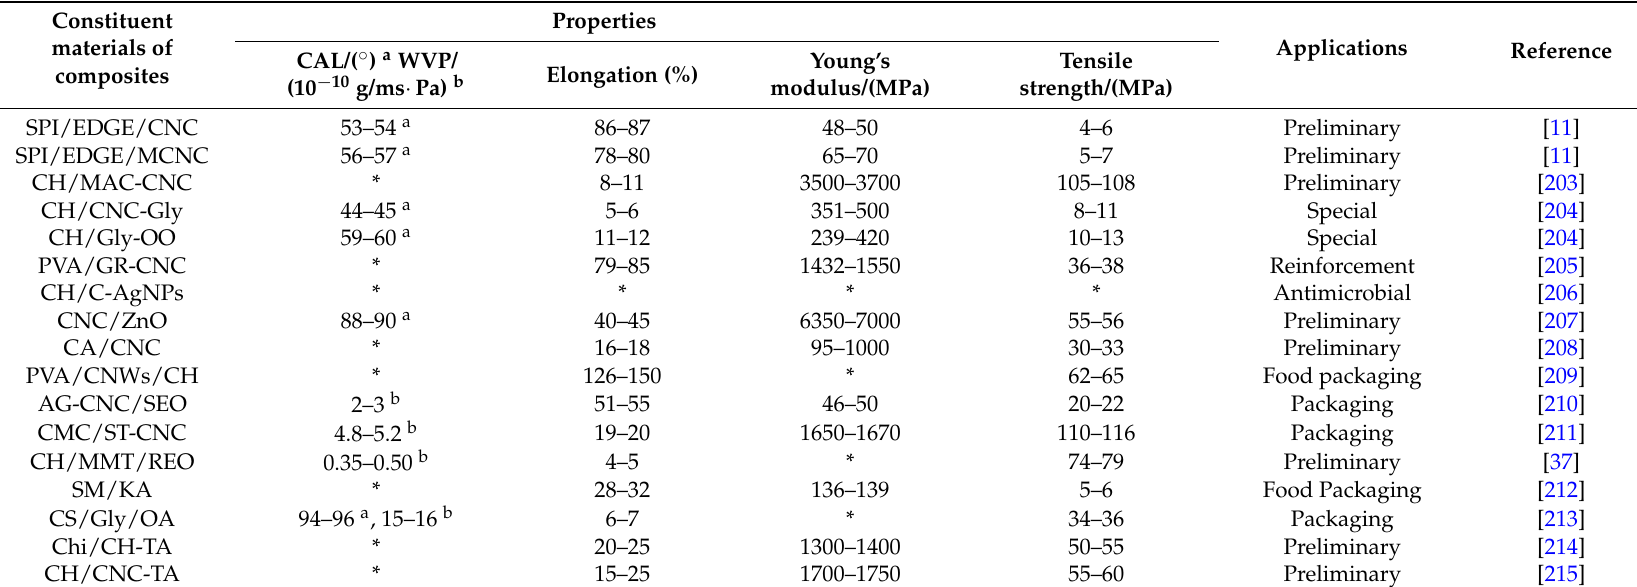
Table 4. Comparison of mechanical properties of various bionanocomposite films at maximum load. (*) indicating the unavailability of the relevant